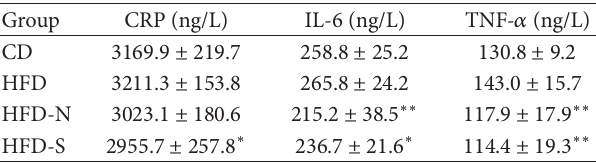
Table 1: Effect of niacin and simvastatin on plasma